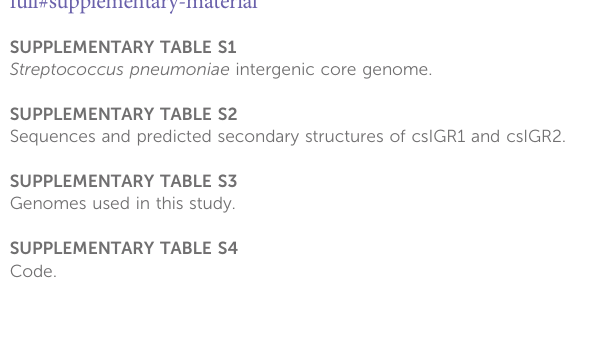
SUPPLEMENTARY TABLE S2 Sequences and predicted secondary structures of csIGR1 and csIGR2. SUPPLEMENTARY TABLE S3 Genomes used in this study. SUPPLEMENTARY TABLE S4